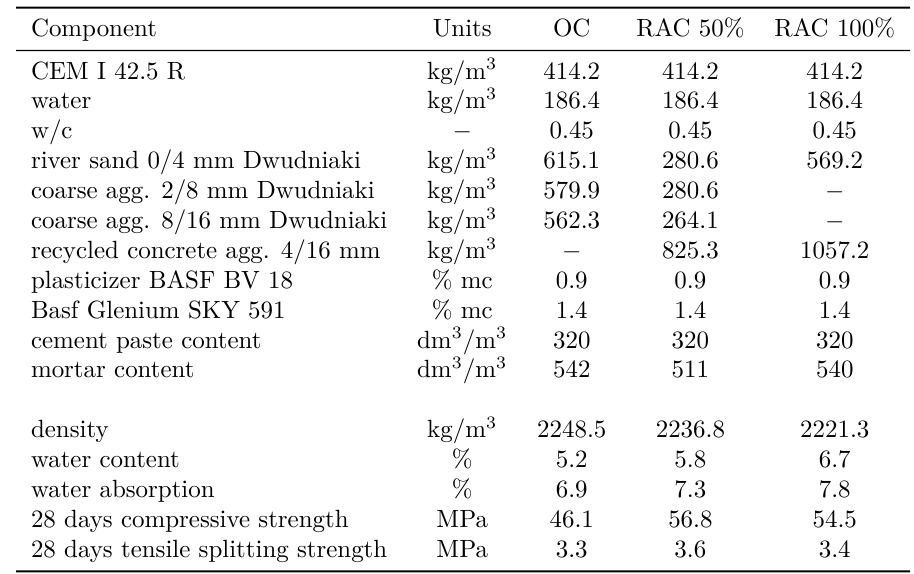
Table 1. Mix design and